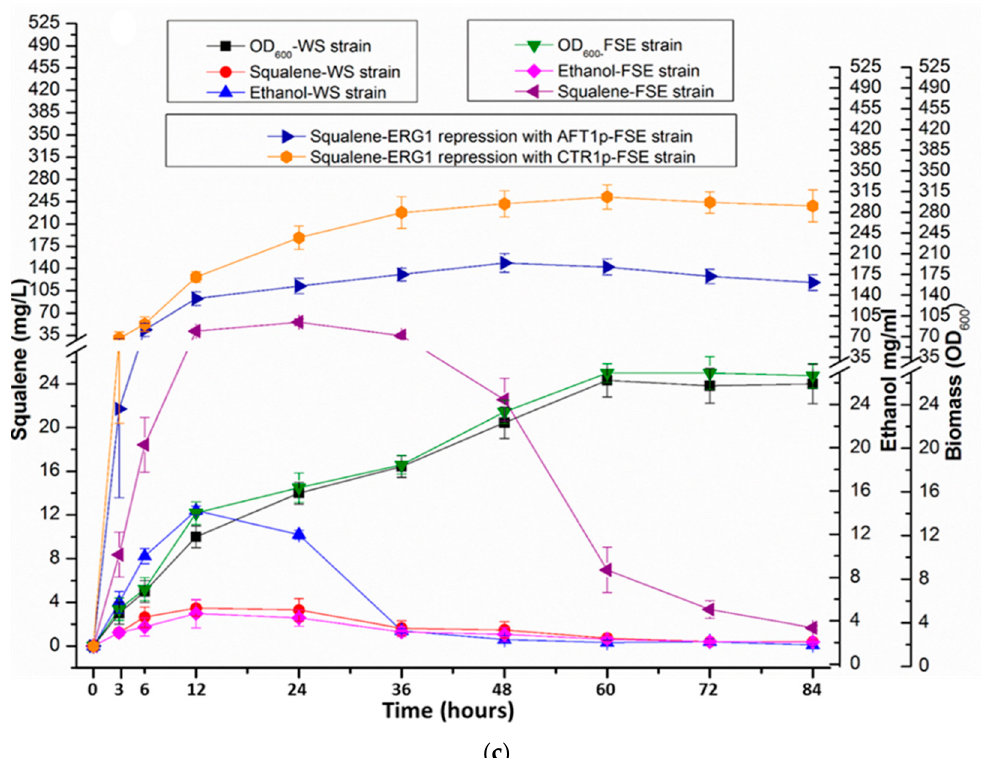
Figure 4. ( a ) Optimization of squalene overproduction in FSE strain. Production of squalene in FSE strain was optimized by overexpressing the DGA1 and downregulation of ERG1 using AFT1p and CTR1p repressible promoters. By overexpressing DGA1 and downregulation of ERG1 using CTR1p maximum amount of squalene was produced in FSE strain. Error bars represent the standard deviation of biological triplicate. (b) Dose optimization of metals ion for the downregulation of ERG1 to optimize the squalene production in FSE strain. Di ff erent concentrations of Fe 2 + and Cu 2 + including, 100 uM, 150 uM, 200 uM, 250 uM, and 300 uM were tested to repress the AFT1p and CTR1p respectively. CTR1p was strongly repressed by Cu 2 + at 200 uM, while AFT1p was strongly repressed by Fe 2 + at 250 uM. The expression of ERG1 was strongly downregulated using CTR1p at 200 uM of Cu 2 + compared to the AFT1p at 250 uM of Fe 2 + . Error bars represent the standard deviation of biological triplicate. (c) Time course of squalene and ethanol co-production in FSE strain. Engineered FSE strain produced the maximum amount of squalene till 24 h of growth and started consuming it after 24 h of fermentation. The downregulation of ERG 1 by AFT1p and CTR1p separately caused the maximum accumulation of squalene up to 48 h and 60 h, respectively, in FSE strain. FSE strain producing maximum titer of squalene by repressing ERG1 with CTR1p also reduced the production of ethanol.